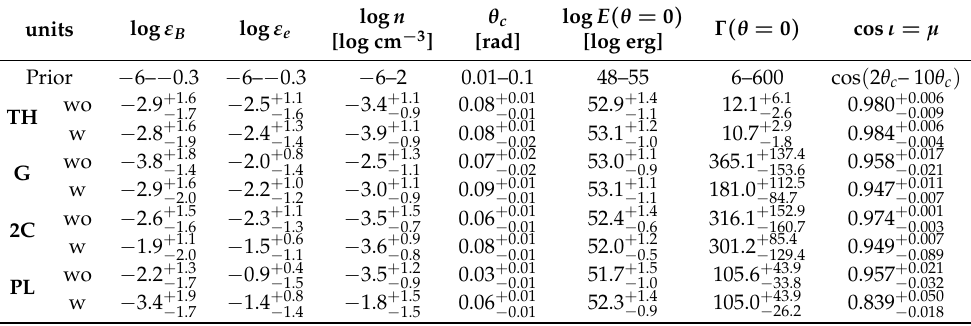
Table 1. The prior range and central values for the fit parameters from the posterior distributions for each of the jet structure models with (w) and without (wo) lateral spreading for lightcurve fits to the broadband afterglow data to GW170817/GRB170817A. The posterior upper and lower bounds are represented by the 16th and 84th percentiles and the central value by the